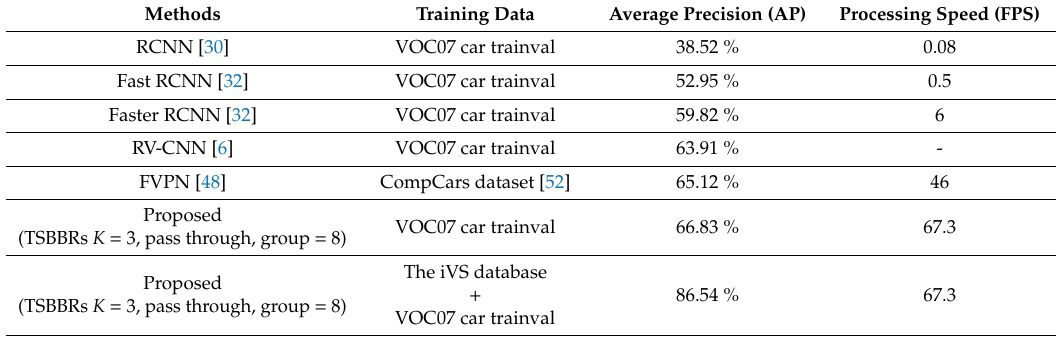
Table 13. Experiment results of the Pascal VOC 2007 car dataset.